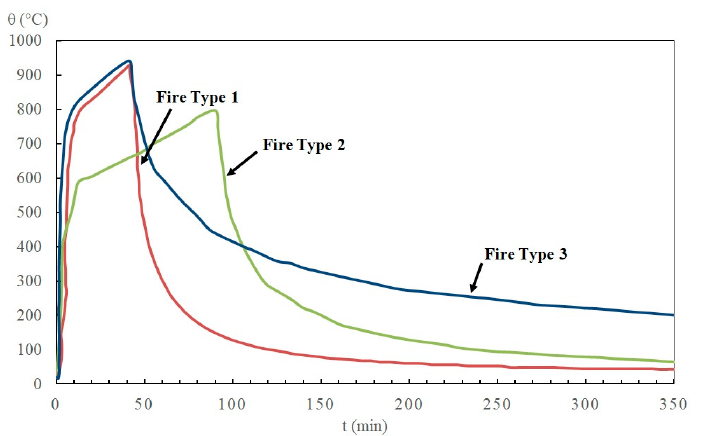
Figure 3. Fire scenarios validation model (Adapted with permission from Guo and Bailey [16]).